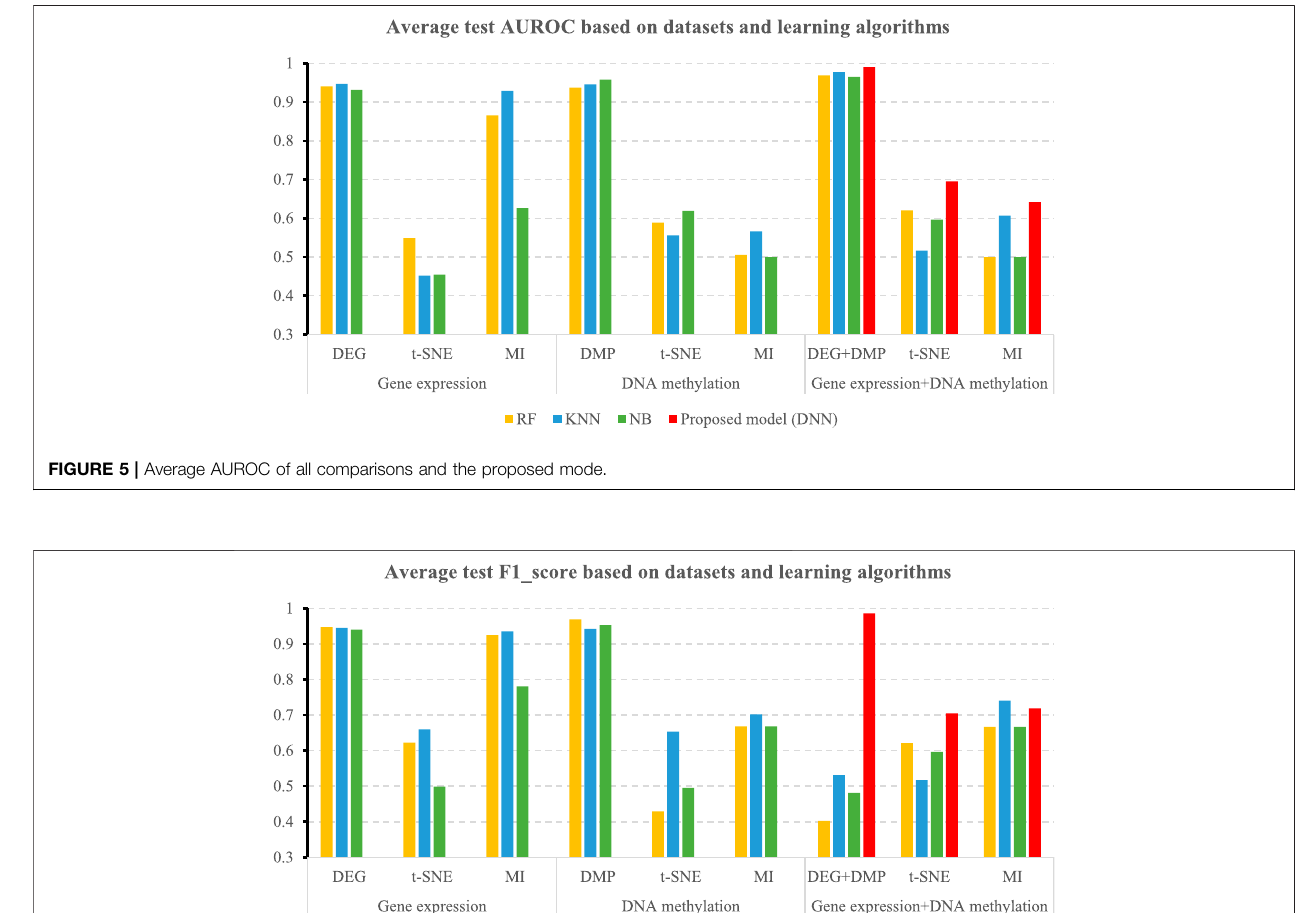
TABLE 6 | Selected genes from gene expression and DNA methylation and comparison with LUAD database. Each Ffold